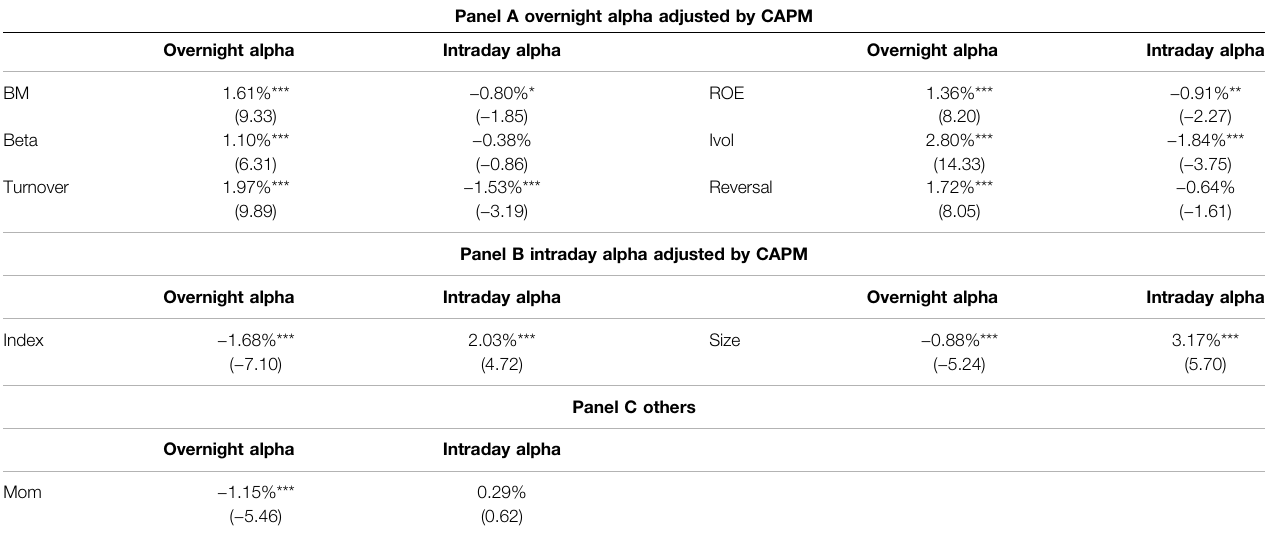
TABLE5| Overnight/intradayabnormalreturnofanomaliesforA-sharesstocks.Thistablereportsabnormalreturntoofvariouscross-sectionalstrategiesduringthedayvs. at night for A-shares stocks. In Panel A, we examine the overnight/intraday abnormal return of four risk-related fi nancialanomalies (beta, idiosyncratic volatility,turnover, short-term reversal) and two fi rm characteristics related fi nancial anomalies (value and probability). In Panel B, we examine the overnight/intraday abnormal return of the momentum anomaly. The de fi nition of the fi nancial anomalies and the detailed zero-strategies based on these anomalies are explained in Section 4.2.1 and Section 4.2.2 . t -statistics are calculated by correcting standard errors for serial-dependence with 12 lags. *,**,*** represent that the results are 10, 5,1% statistically signi fi cant, respectively. The sample period is 2001 –